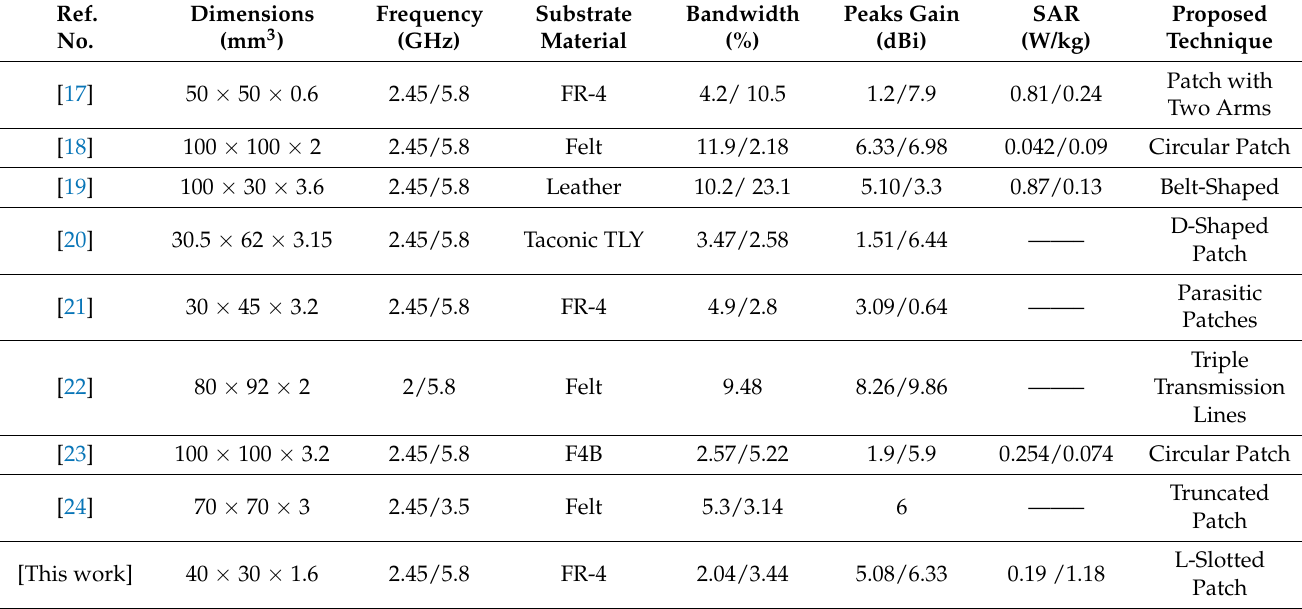
Table 4. Comparison of different on- and off-body antennas’